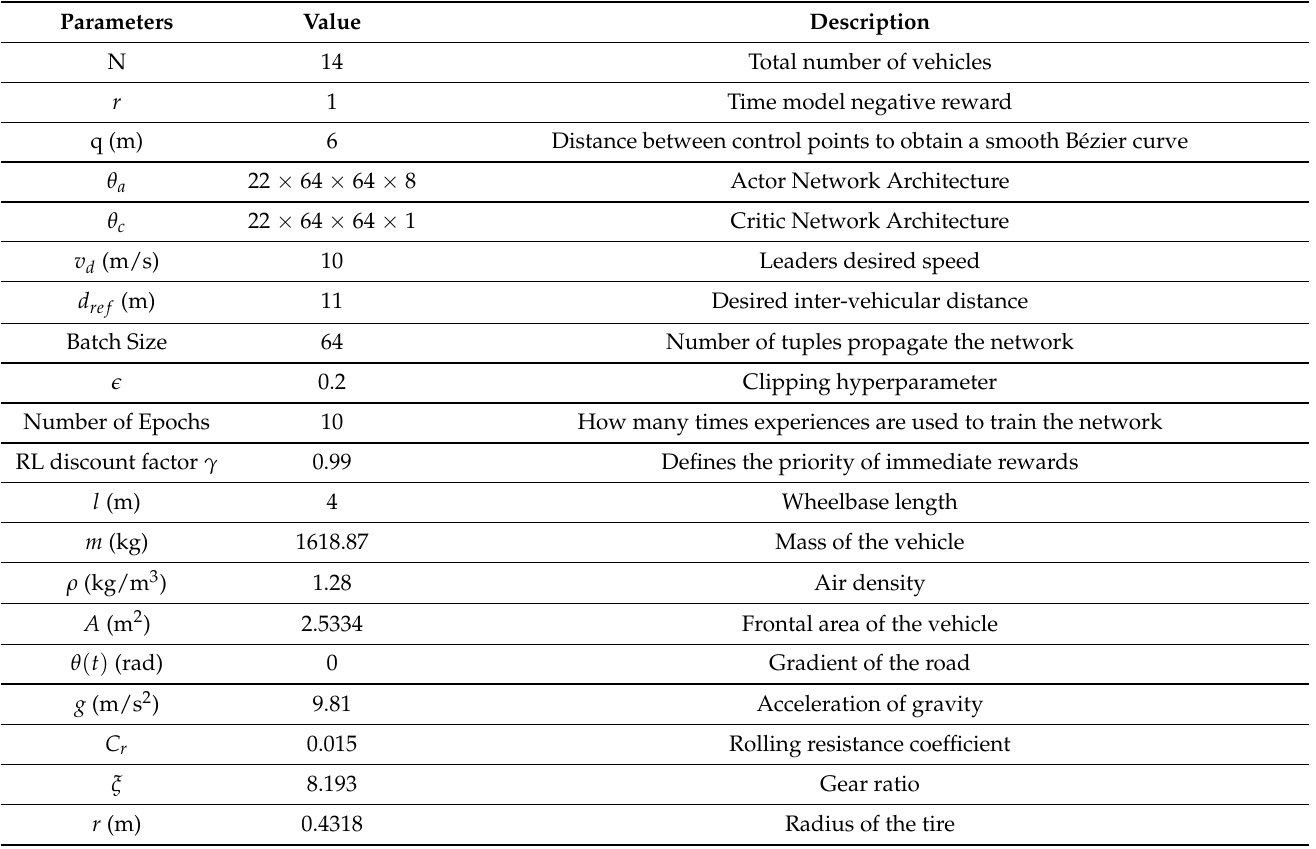
Table 2. Simulation